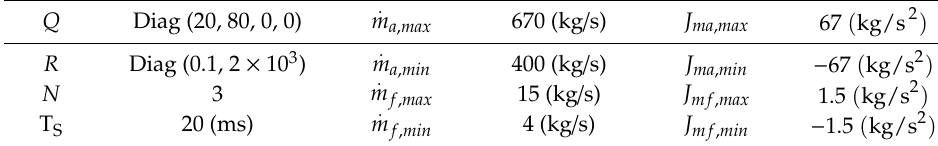
Table 1. MPC controller parameters.